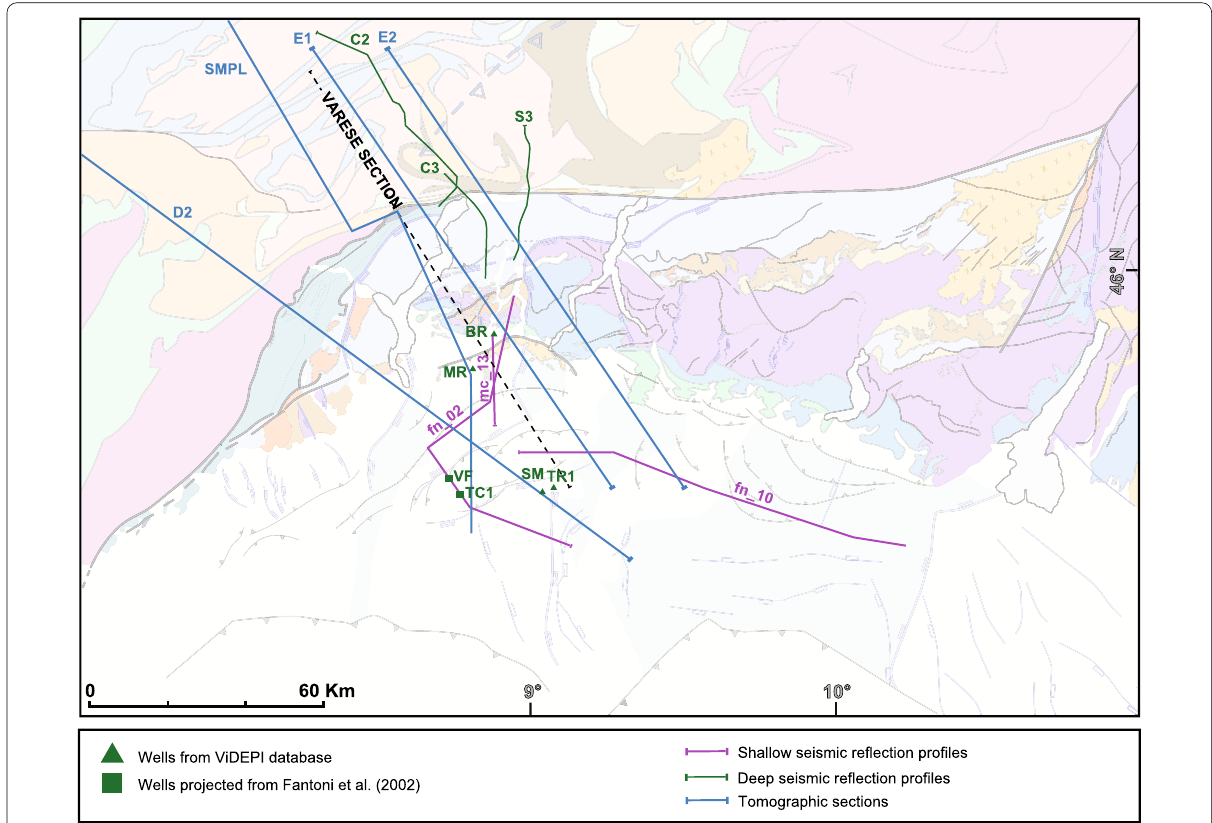
Fig. 3 Datasets and sources used for the building of the Varese Section, including: deep seismic reflection profiles (C2 and S3: Schumacher, 1997; C2: Pfiffner & Heitzmann, 1997), shallow seismic reflection profiles (mc_13: Michetti et al., 2012; fn_02: Fantoni et al., 2002; fn_10: Fantoni & Franciosi, 2010), tomographic sections (E1, E2 and D2: Diehl et al., 2009, 2017; SMPL: Simplon section after Rosenberg & Kissling, 2013), well logs BR: Brenno; MR: Morazzone; SM: Settimo Milanese; TC 1: Trecate 1; TR1: Trenno 1; VF: Villa Fortuna). Same Fig. 1